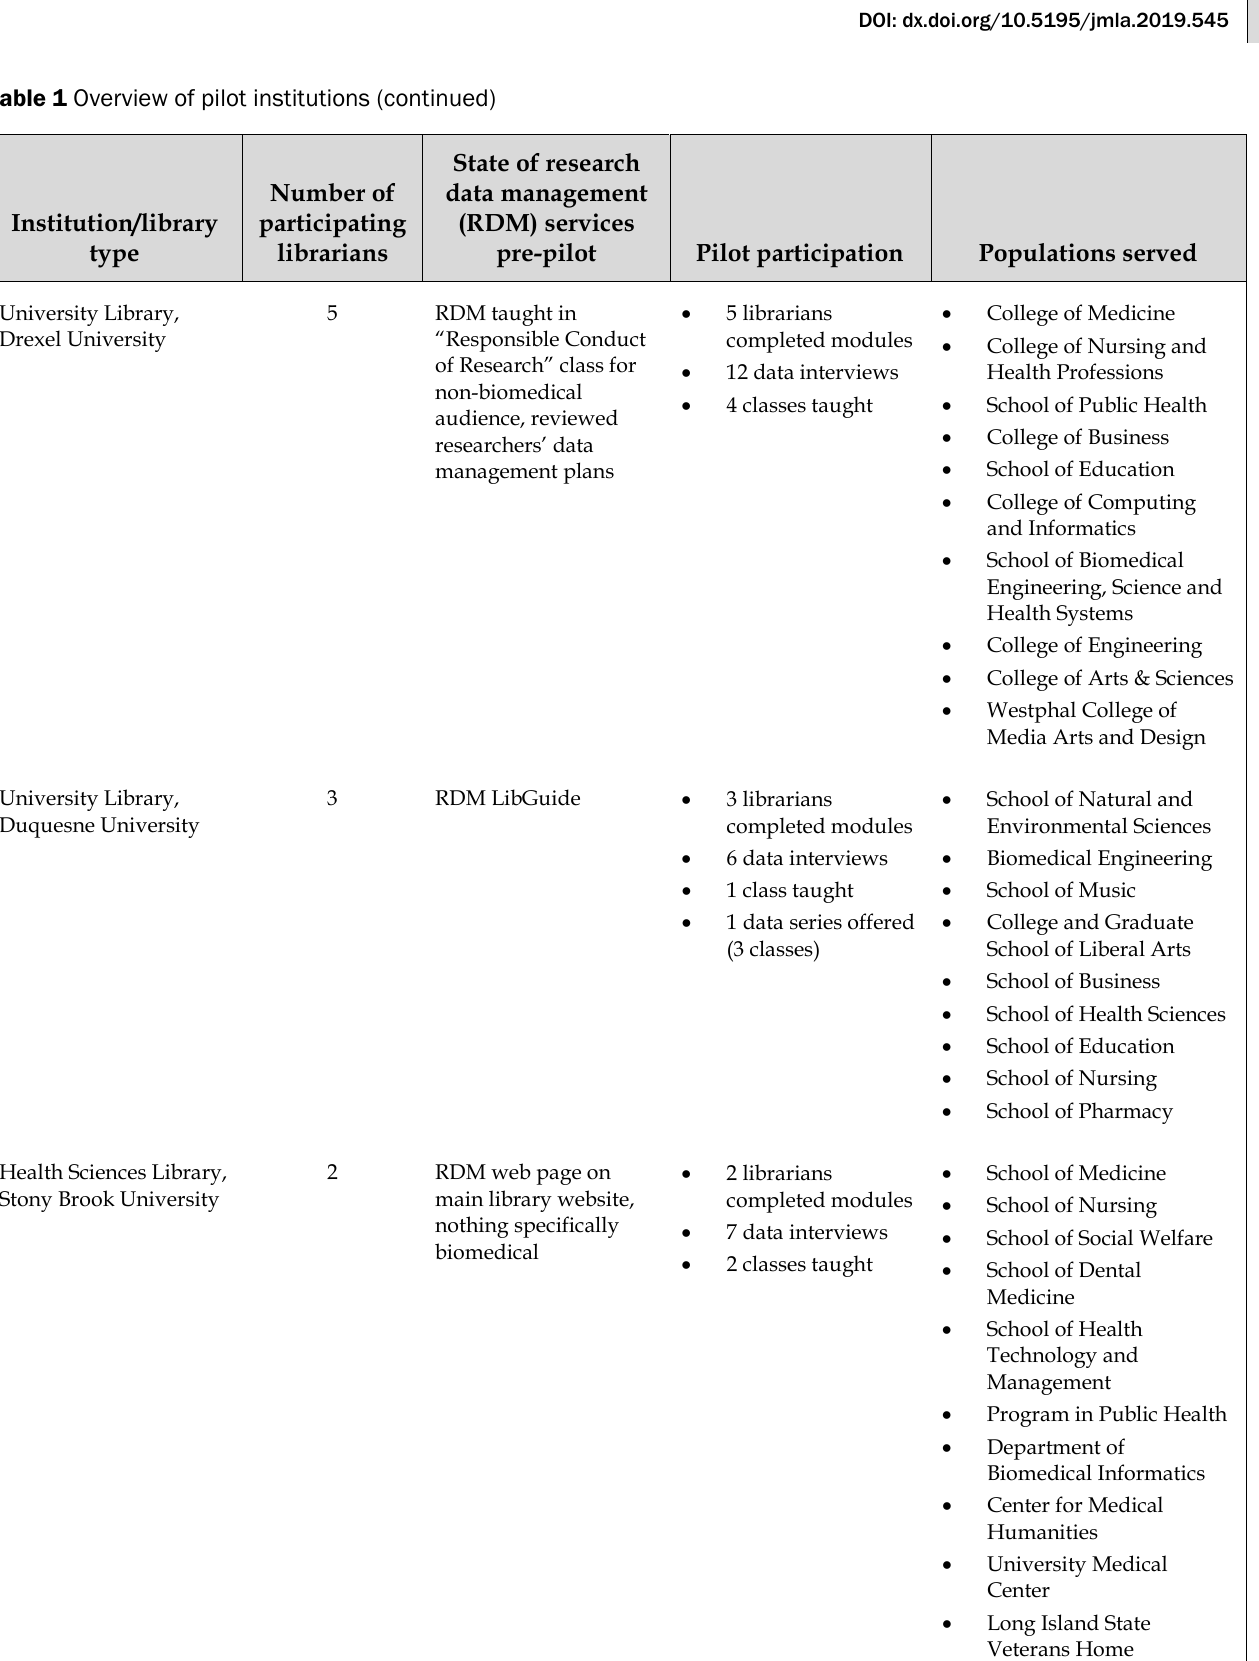
Table 1 Overview of pilot institutions